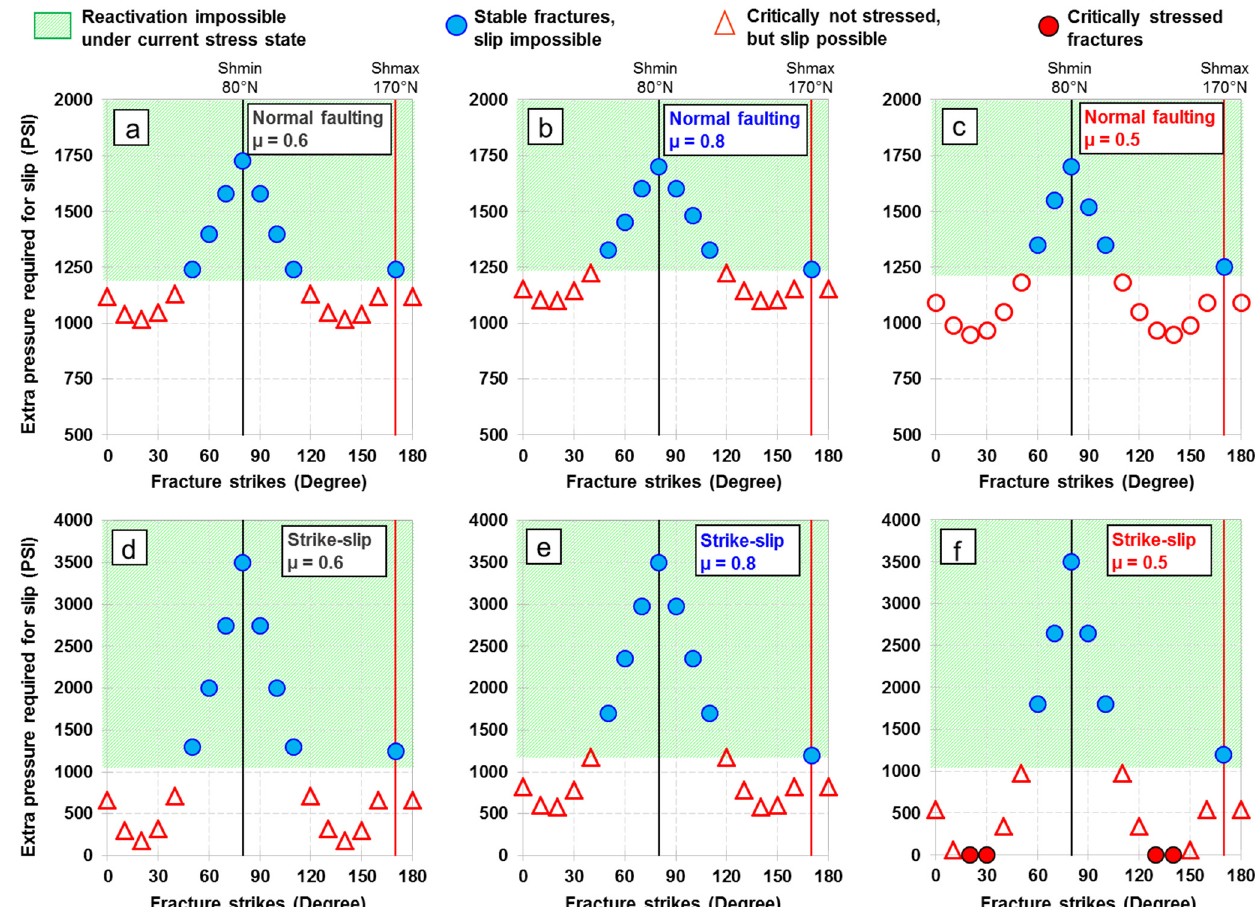
Figure 10. Natural fracture reactivation potential in the Turonian interval considering ( a – c ) normal faulting and ( d – f ) strike ‐ slip stress regime at various coefficient of internal friction ( μ ) values. faulting and ( d – f ) strike-slip stress regime at various coefficient of internal friction ( µ )